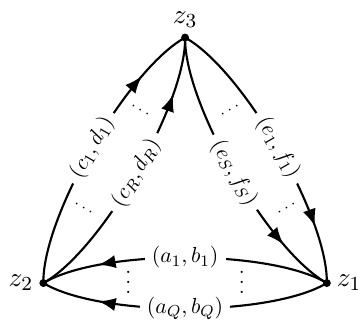
Figure 2 . Depiction of the worldsheet graph associated with the trihedral modular graph